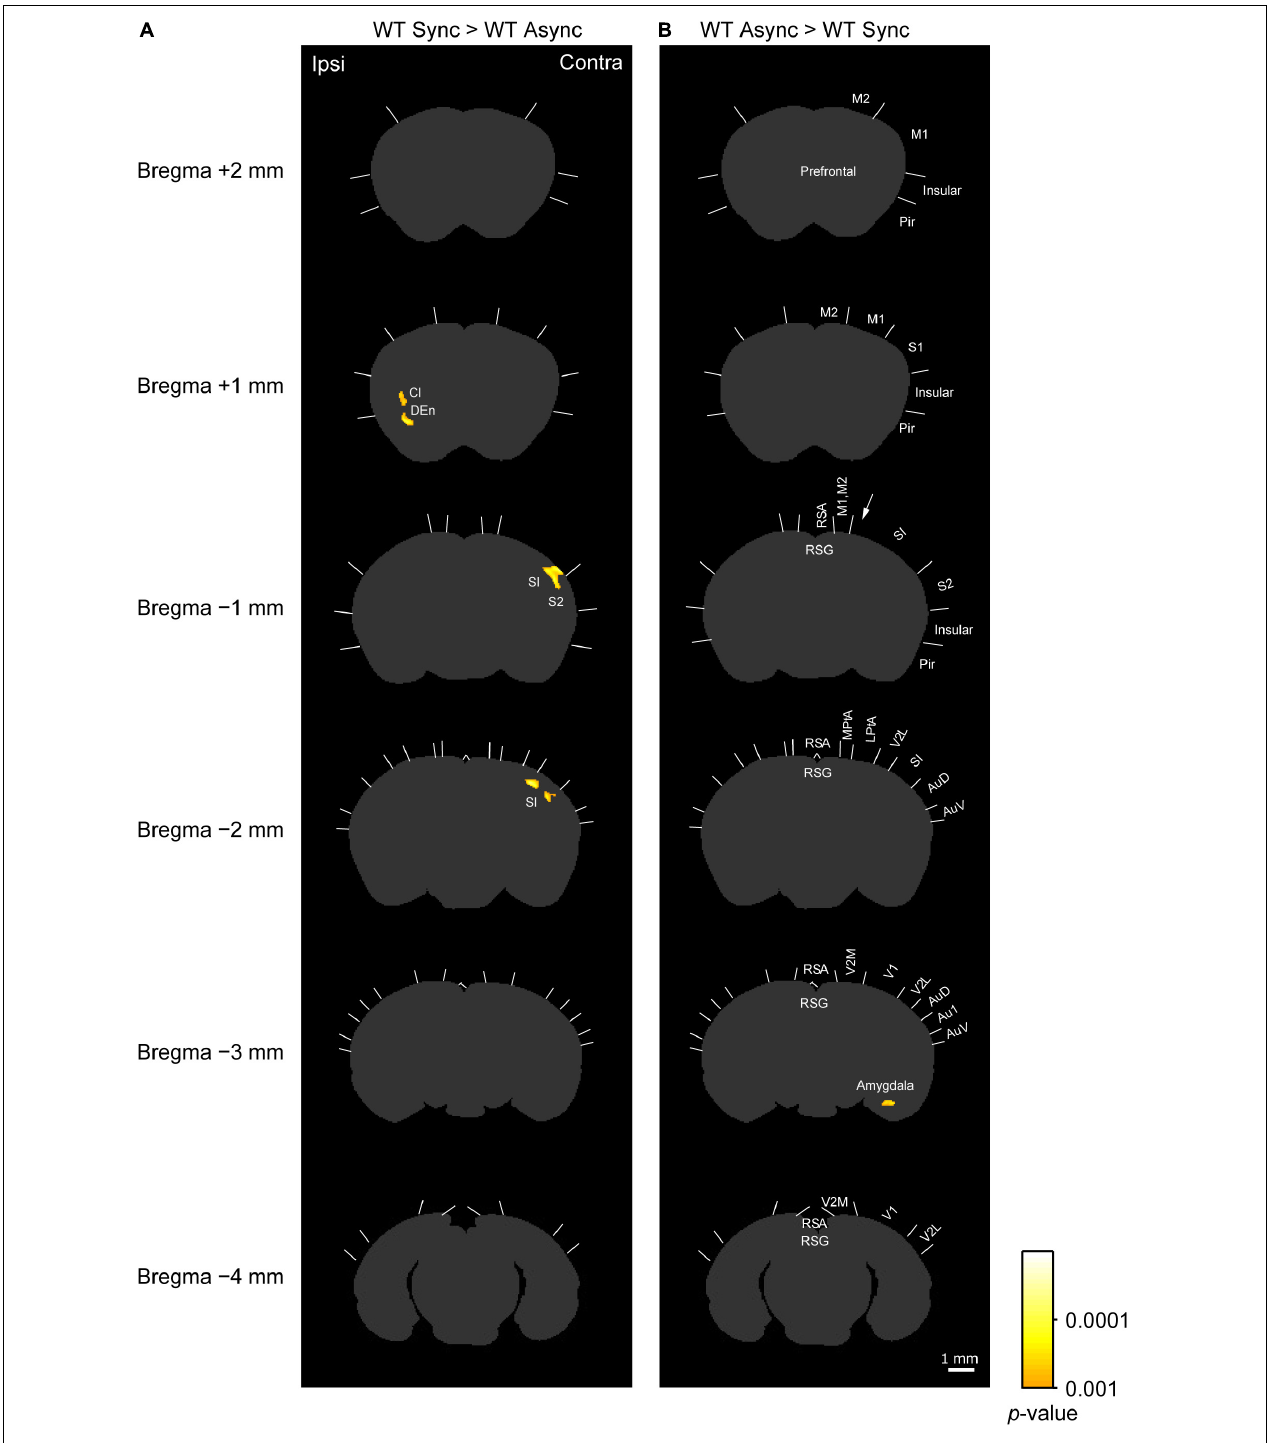
FIGURE 4 | c-Fos imaging (statistical parametric mapping): Comparison between Synchronous and Asynchronous conditions in WT mice. (A) Areas that showed significantly higher densities of c-Fos-positive cells in the WT mice exposed to the synchronous condition (WT Sync) than in those exposed to the asynchronous condition (WT Async) after the cluster level control. Pixel-by-pixel t-tests were applied between two groups. (B) Areas that showed significantly higher c-Fos-positive cell densities in the WT mice exposed to the asynchronous condition (WT Async) than in those exposed to the synchronous condition (WT Sync) after the cluster level control. Boundaries between regions were determined by reference to the brain atlas (Paxinos and Franklin, 2001). Cl, claustrum; DEn, dorsal endopiriform nucleus. Scale bar: 1 mm.